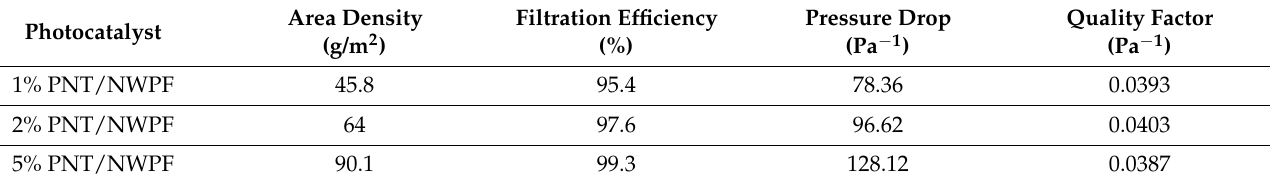
Table 2. Summary of filtration efficiency, pressure drop, and quality factor of PNT/NWPF air